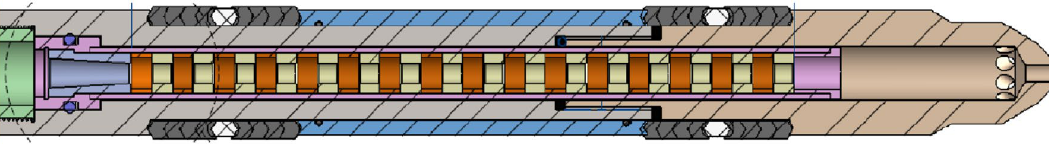
Fig. 2 CAD image of the 6 mm diameter reductions—9 mm diameter expansions in the regulator